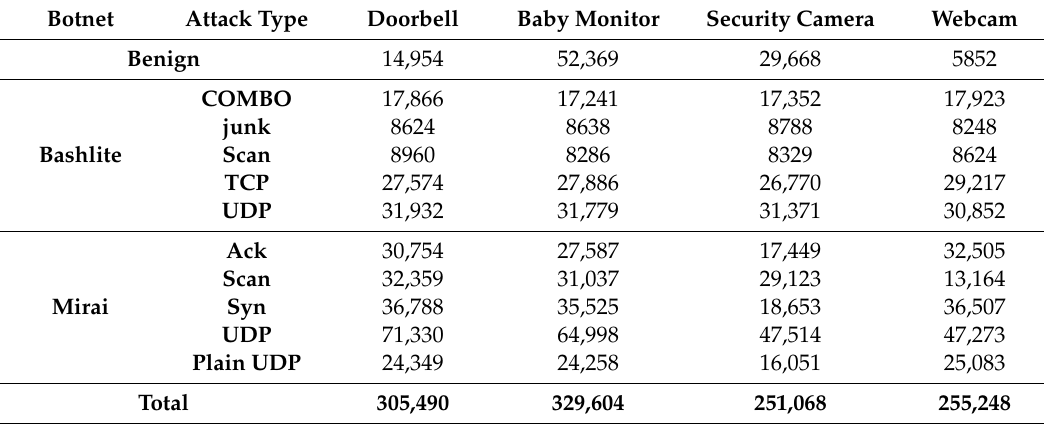
Table 7. Number of samples used in this